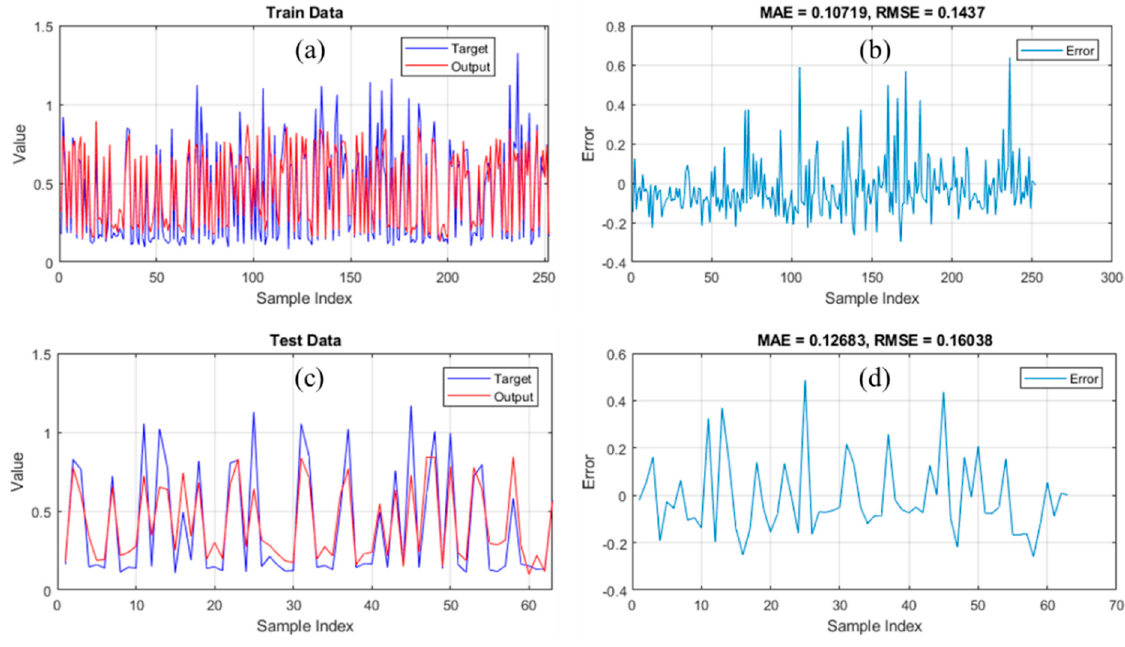
Figure 6. The ANN results for the ( a , b ) training and ( c , d ) testing data.